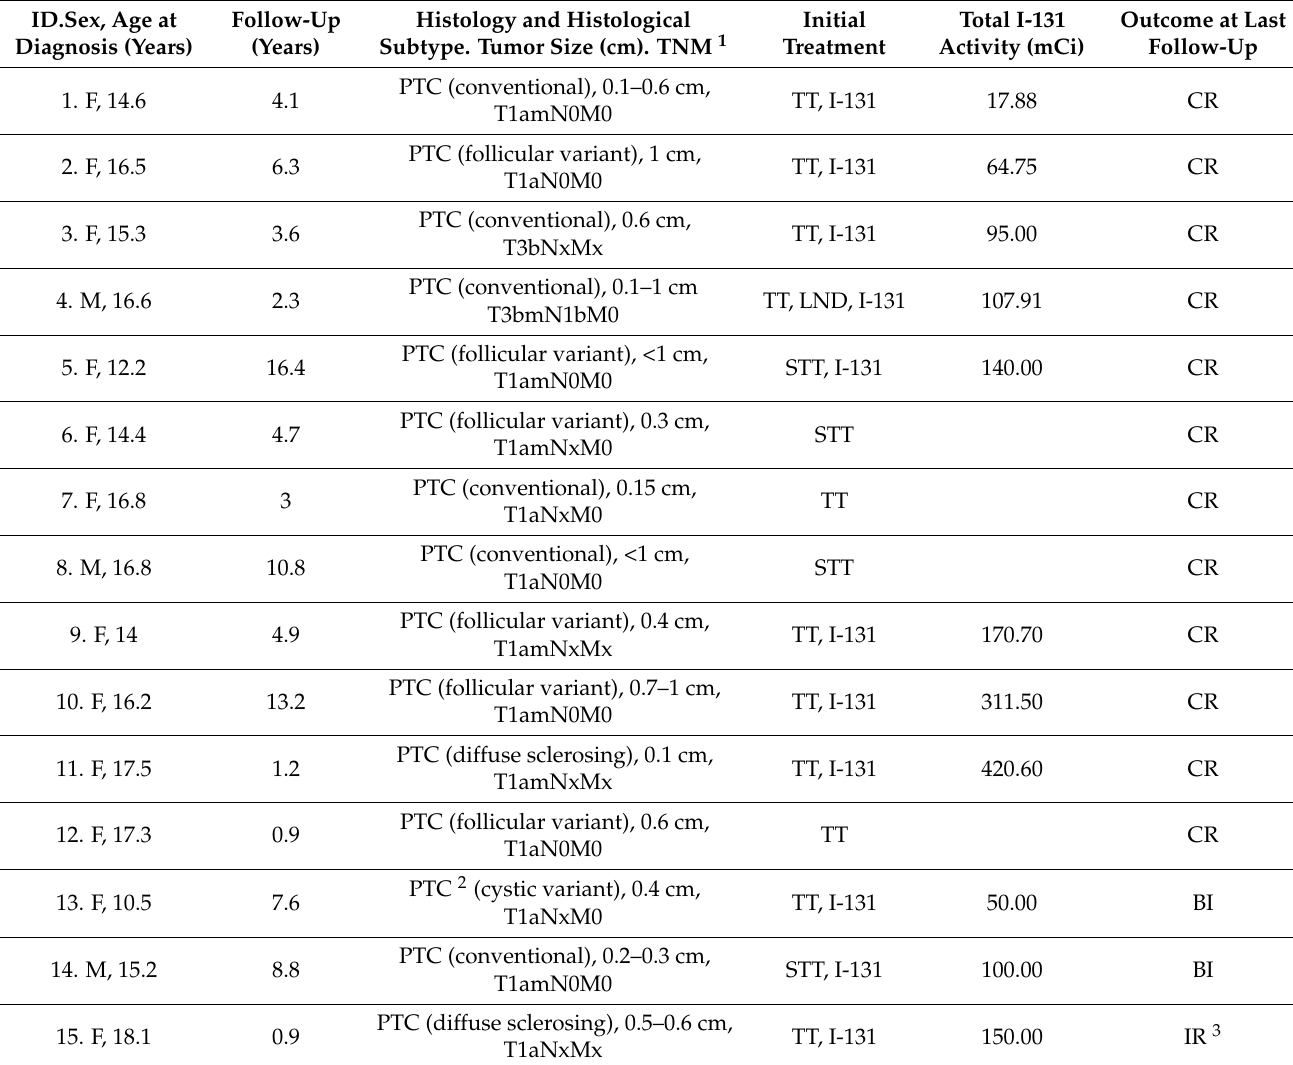
Figure 1. Distribution of thyroid microcarcinoma cases in children/year. Table 2. Outcome of the individual patients with